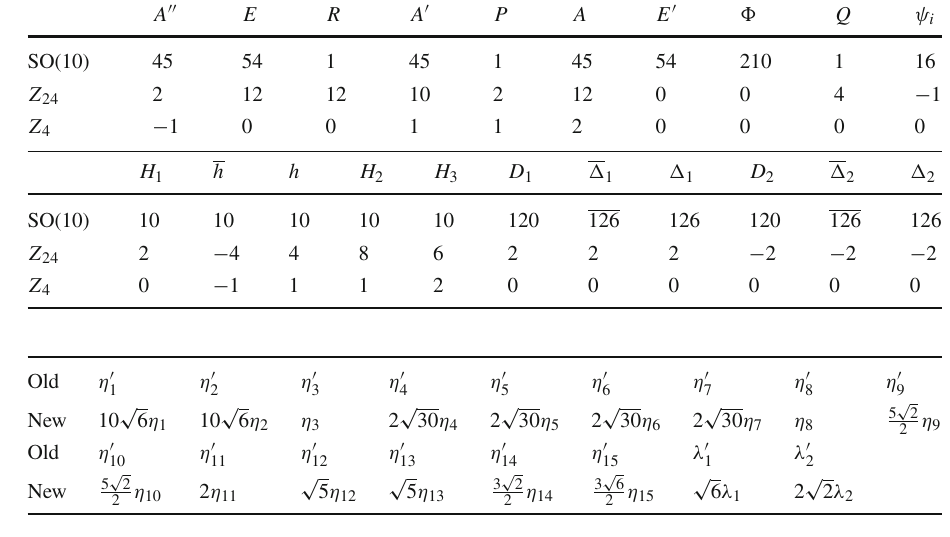
Table 2 Redefinitions of the